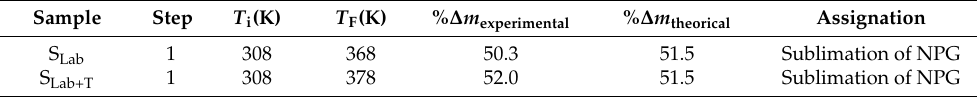
Figure 9. TGA measurement of S Lab and S Lab+T samples, from 310 K up to 400 K. Table 4. Thermoanalytic data for S Lab and S Lab+T samples. Table 4. Thermoanalytic data for S Lab and S Lab+T samples.